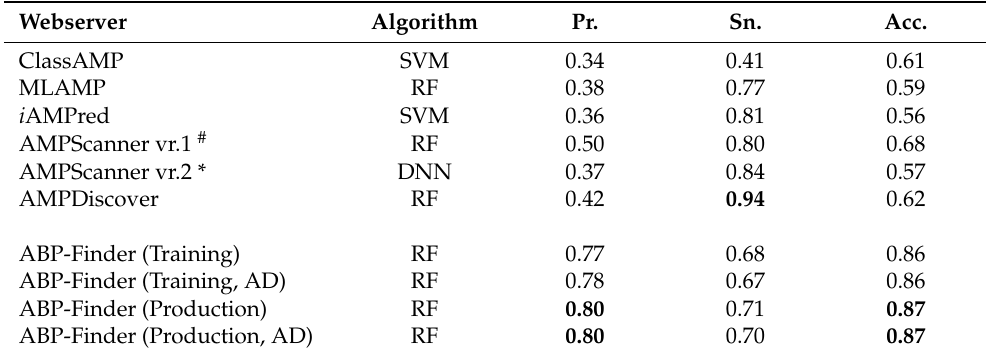
Table 3. Comparison with external predictors in the test set. The values in bold denote the best performance for a given